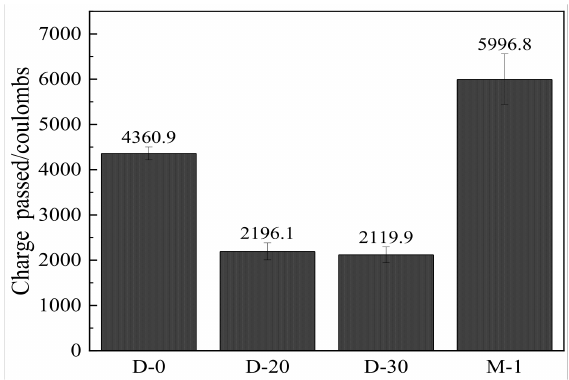
Figure 7. RCPT test results for part of the